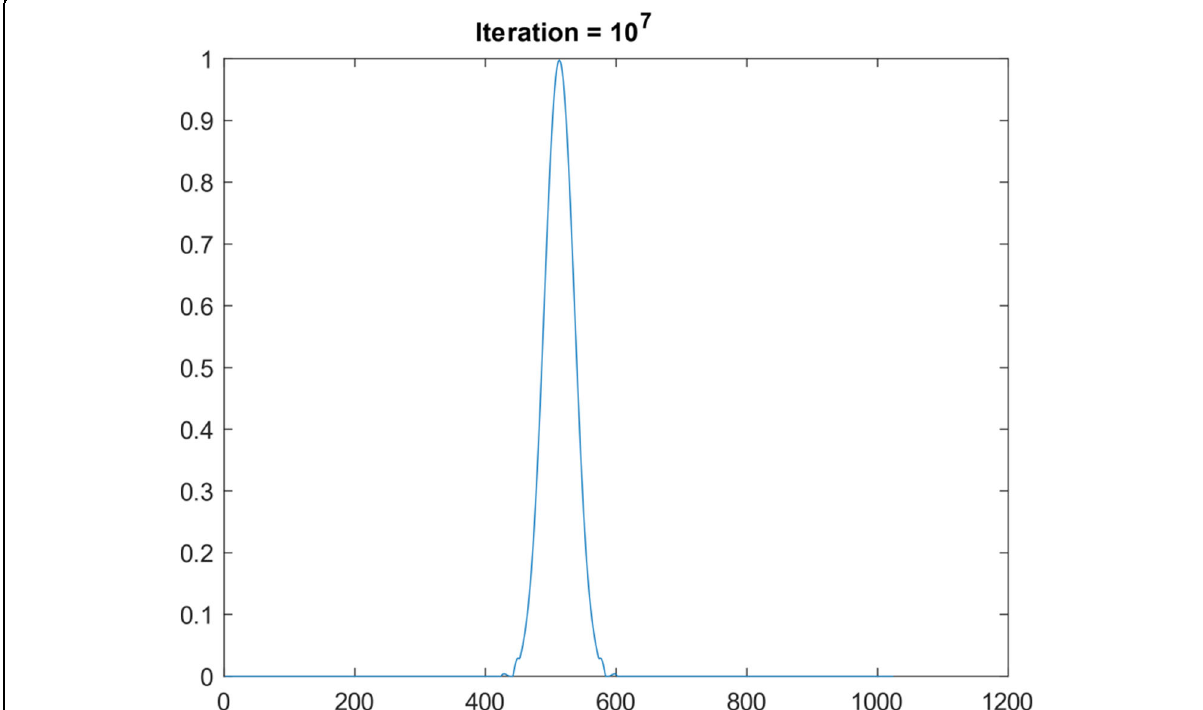
Fig. 13 Restored the Gaussian function after 10 7 iteration of suggested algorithm